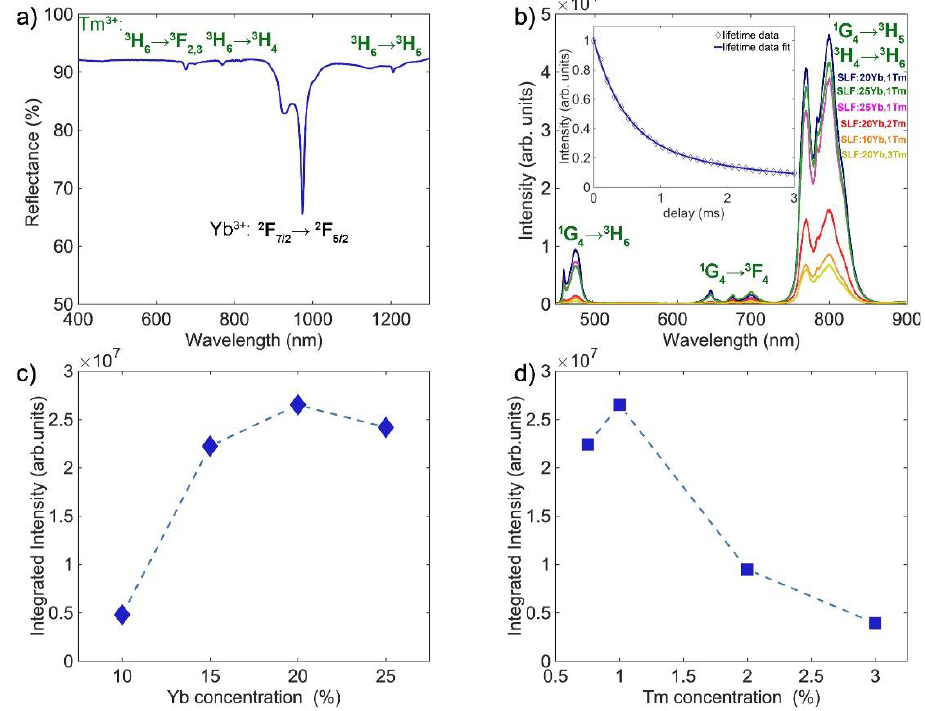
Figure 4. ( a ) Diffuse reflectance spectra of representative SLF:20Yb,1Tm nanophosphor. ( b ) PL spectra of SLF: xYb, yTm nanophosphors measured upon 980 nm excitation (Inset: UC lifetime profiles of Tm 3+ ( 3 H 4 → 3 H 6 transition) of representative SLF:20Yb,1Tm). ( c ) Yb 3+ concentration dependence of integrated UC emission intensity of SLF nanophosphor. ( d ) Tm 3+ concentration dependence of integrated UC emission intensity of SLF